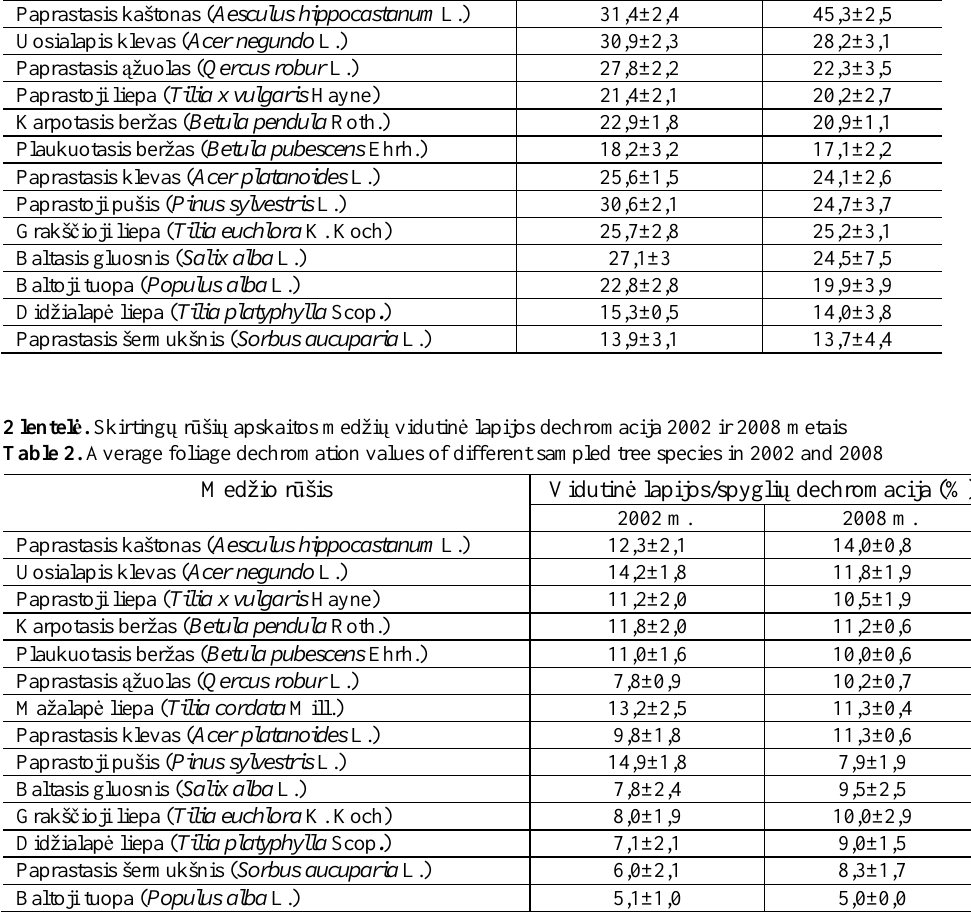
Table 3. Average values of fruiting and amount of dry branches in the crowns of different sampled tree species in 2008 Vidutinis der ė jimo Vidutinis saus ų Medžio r ū šis laipsnis (balais) šak ų kiekis (%) Mažalap ė liepa ( Tilia cordata Mill.) 1,3±0,1 13,0±0,7 Paprastasis kaštonas ( Aesculus hippocastanum L.) 1,3±0,2 11,4±1,8 Paprastoji liepa ( Tilia x vulgaris Hayne) 1,3±0,1 10,4±0,7 Karpotasis beržas ( Betula pendula Roth.) 1,2±0,1 10,8±0,8 Plaukuotasis beržas ( Betula pubescens Ehrh.) 1,2±0,2 10,2±0,5 Uosialapis klevas ( Acer negundo L.) 1,2±0,2 14,8±1,5 Paprastasis klevas ( Acer platanoides L.) 1,1±0,1 9,5±0,8 Paprastasis ą žuolas ( Qercus robur L.) 0,8±0,1 10,6±0,7 Paprastoji pušis ( Pinus sylvestris L.) 1,3±0,1 15,3±0,9 Didžialap ė liepa ( Tilia platyphylla Scop . ) 2,3±0,7 6,7±1,7 Baltasis gluosnis ( Salix alba L.) 1,3±0,2 13,9±2,1 Paprastasis šermukšnis ( Sorbus aucuparia L.) 1,3±0,7 14,3±3,3 Grakš č ioji liepa ( Tilia euchlora K. Koch) 1,3±0,3 10,0±1,8 Baltoji tuopa ( Populus alba L.) 0